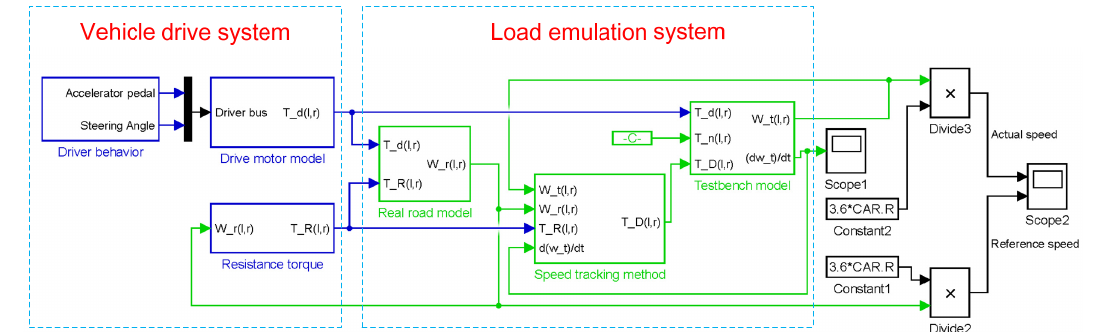
Figure 9. MATLAB/Simulink model of the single side test bench.